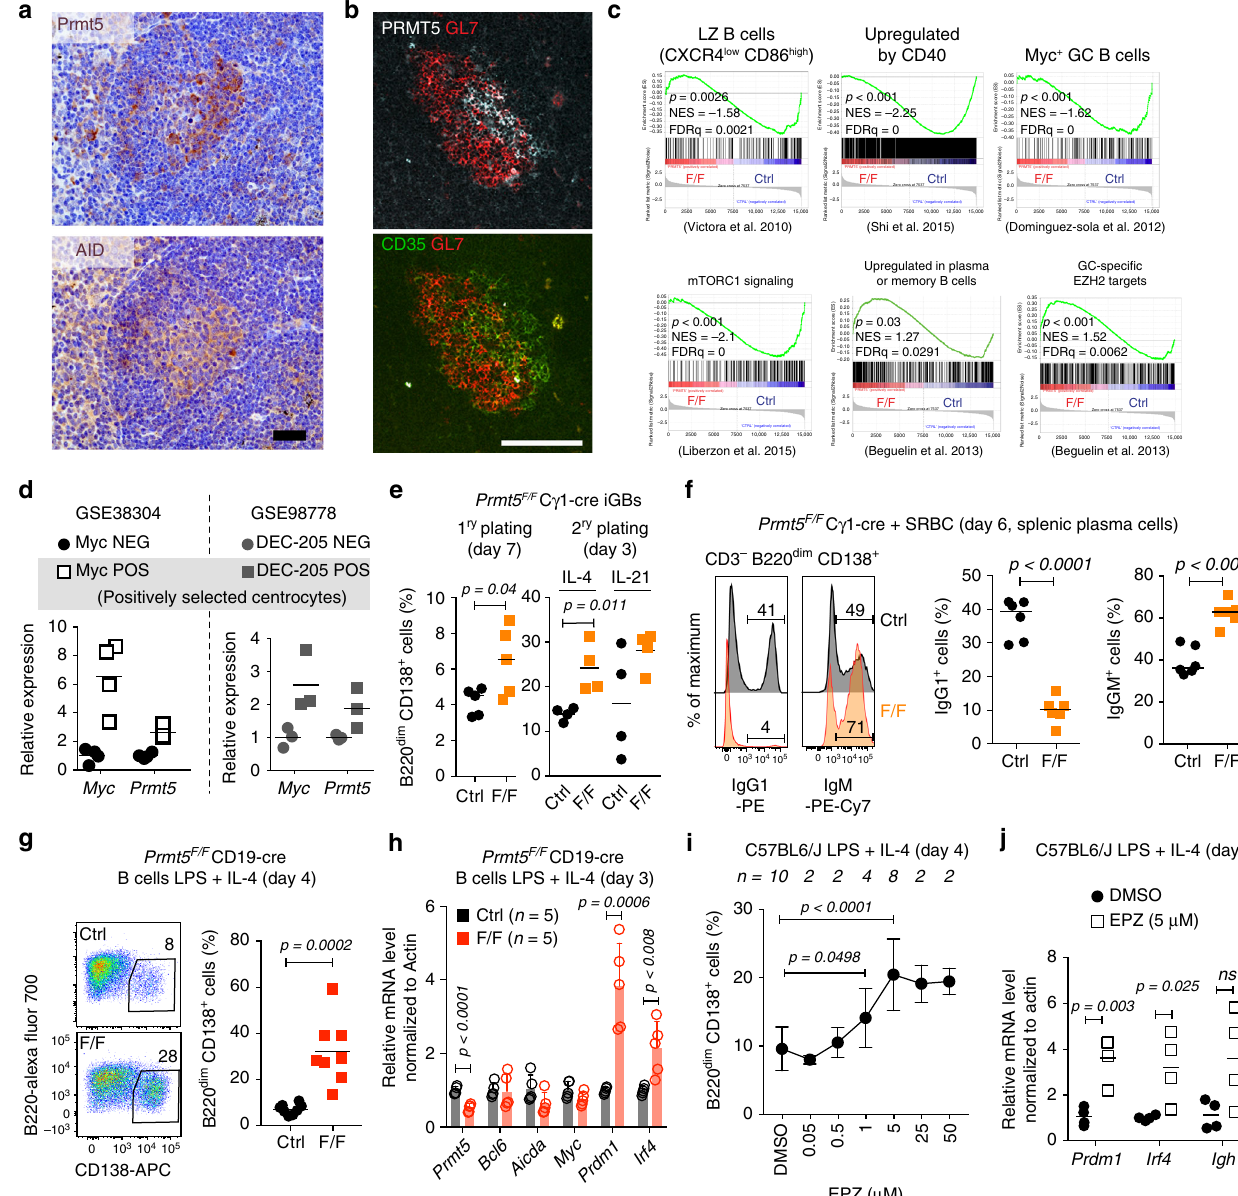
Fig. 9 Prmt5 acts in the light zone to prevent B cell differentiation. a IHC images for Prmt5 and AID, as GC marker, on consecutive spleen sections from wt mice 14 days post-NP-CGG immunization. Representative of three mice from two experiments. Scale bar, 40 µ m. b Representative IF on wt mouse spleen section 10 days after SRBC immunization, stained for GL7 CD35 (LZ marker) and Prmt5. Scale bar, 100 µ m. c GSEA of transcriptional changes in Prmt5 F/F C γ 1-cre (F/F) versus C γ 1-cre (Ctrl) iGB cells against the indicated gene signatures. Enrichment was considered signi fi cant for P < 0.05 and FDR < 5%. d Relative gene expression in positively selected GC B cells. e Proportion of plasma cell-like B cells in C γ 1-cre (Ctrl) or Prmt5 F/F C γ 1-cre (F/F) iGB cultures at day 7 post-plating, or at day 3 after replating with 1 ng/mL IL-4 or 10 ng/mL IL-21. Individual mice (symbols) from one experiment are plotted. f Representative fl ow cytometry histograms of intracellular IgG1 and IgM staining of plasma cells in Prmt5 F/F C γ 1-cre (F/F) or C γ 1-cre (Ctrl) mice 6 days post-SRBC immunization. Proportion of IgG1 + and IgM + plasma cells in individual mice (symbols) from two experiments are plotted. g Representative fl ow cytometry plots of plasma cells in CD19-cre (Ctrl) or Prmt5 F/F CD19-cre (F/F) B cells cultured 4 days in LPS and IL-4. Plasma cell proportion for individual mice (symbols) from three independent experiments are plotted. h Gene expression by RT-qPCR in splenic B cells cultured as in g for 3 days. Mean + s.d. mRNA levels normalized to Actin for n mice from two experiments are plotted relative to Ctrl average. i Mean ± s.d. (or ± s.e.m for n = 2) of plasma cell proportion in splenic B cells stimulated with LPS and IL-4 and treated with various EPZ doses for 4 days, are plotted for n mice from one to fi ve experiments. j Gene expression by RT-qPCR in B cells treated with 5 μ M EPZ as in i ; individual mice (symbols) are plotted. Bars indicate mean values in all scatter plots. Signi fi cant p -values throughout are by an unpaired, two-tailed Student's t test except for GSEA, in which statistics are indicated